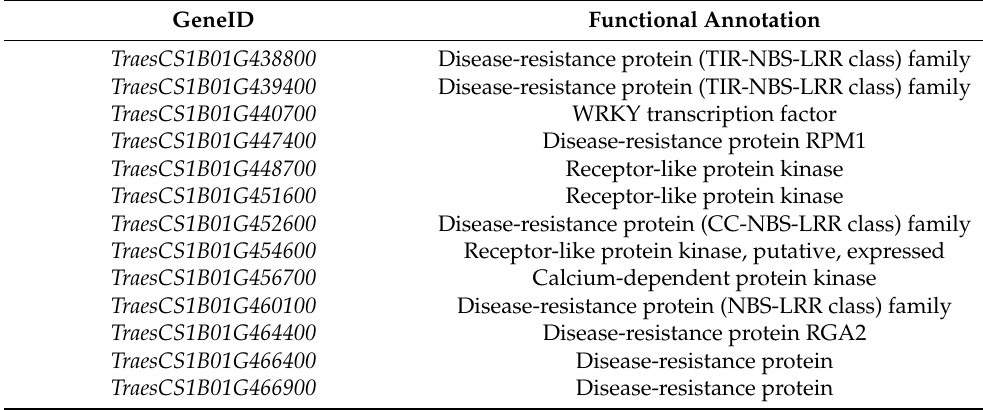
Table 3. The 13 differently expressed genes (DEGs) in the region of QYr.sdau-1B that relate to disease